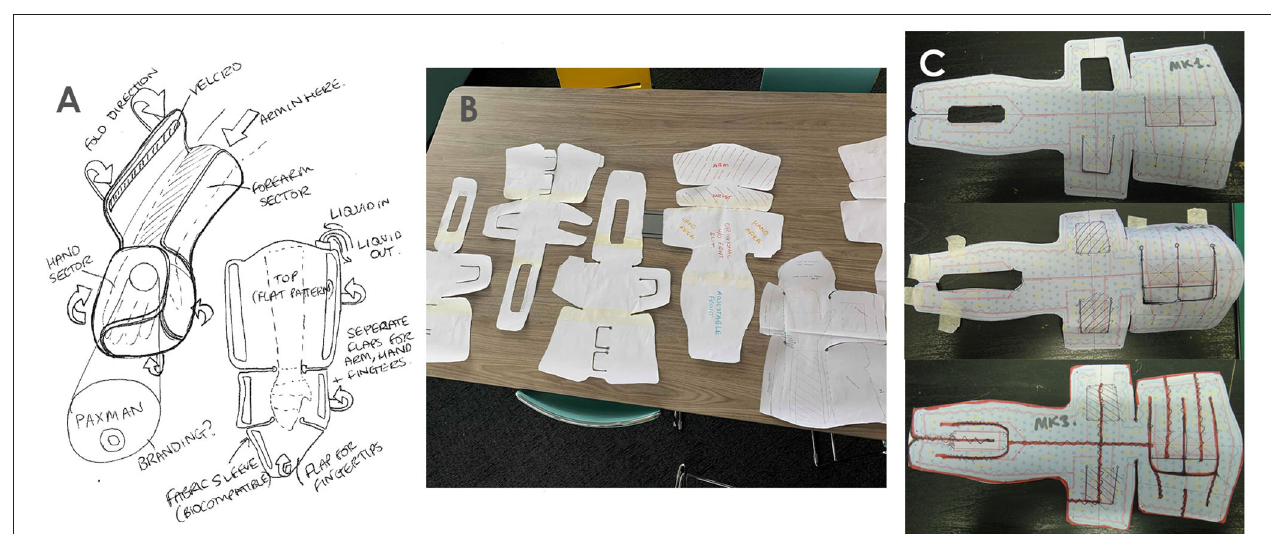
FIGURE 3 | Ideation tools: Sketches (A) Paper sketch modeling - Form (B) , sketch modeling (technical considerations) (C)